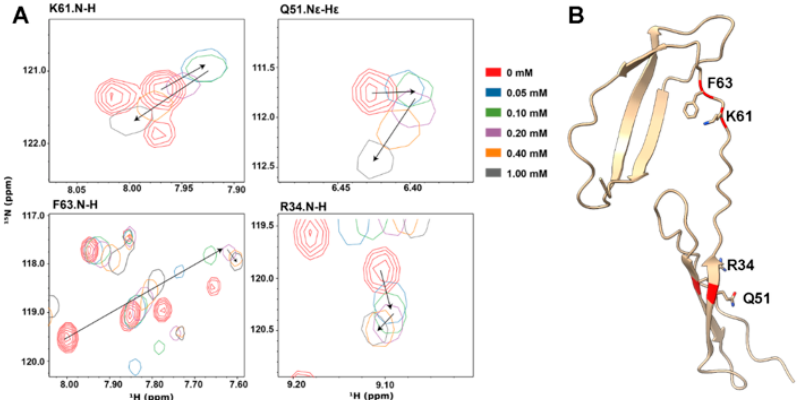
Figure 1. Heparin dp6 induces nonlinear chemical shift migrations in 1 H, 15 N-labeled PTN NMR signals. ( A ) PTN-induced changes in the 15 N-HSQC signals of PTN residues R34, Q51, K61, and F63. 15 N-HSQC contours are colored by concentrations of heparin dp6. ( B ) Ribbon representation of PTN with side chains of R34, Q51, K61, and F63 in the stick form.